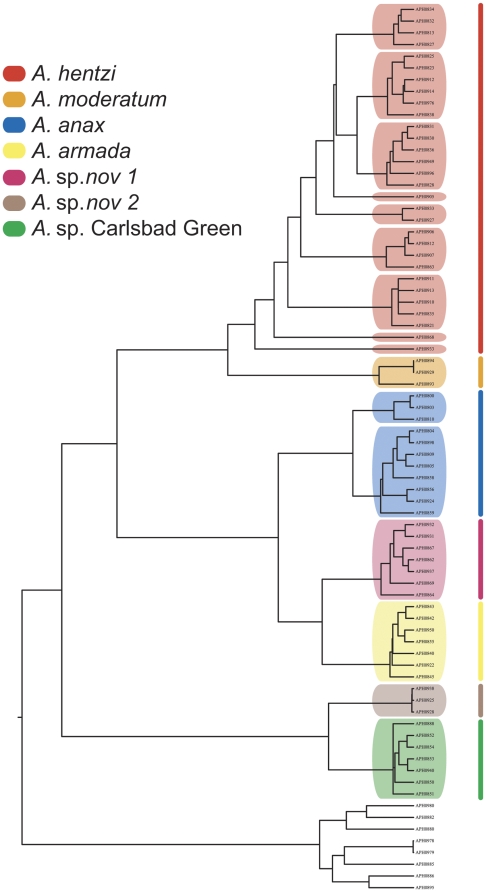
Generalized Mixed Yule Coalescent species delimitation tree.GMYC clusters delimited from the single-threshold model are highlighted and grouped according to their defined species. A total of 13 independent coalescence groups plus 3 singletons (singletons constitute a cluster given more population representatives) were delimited for the ingroup (14 total ML clusters; CI = 14–16). The data revealed strong geographic structuring and phylogenetic gene tree clustering in all putative species groups except A. hentzi. Species and color combinations correspond to those represented in Figure 1.